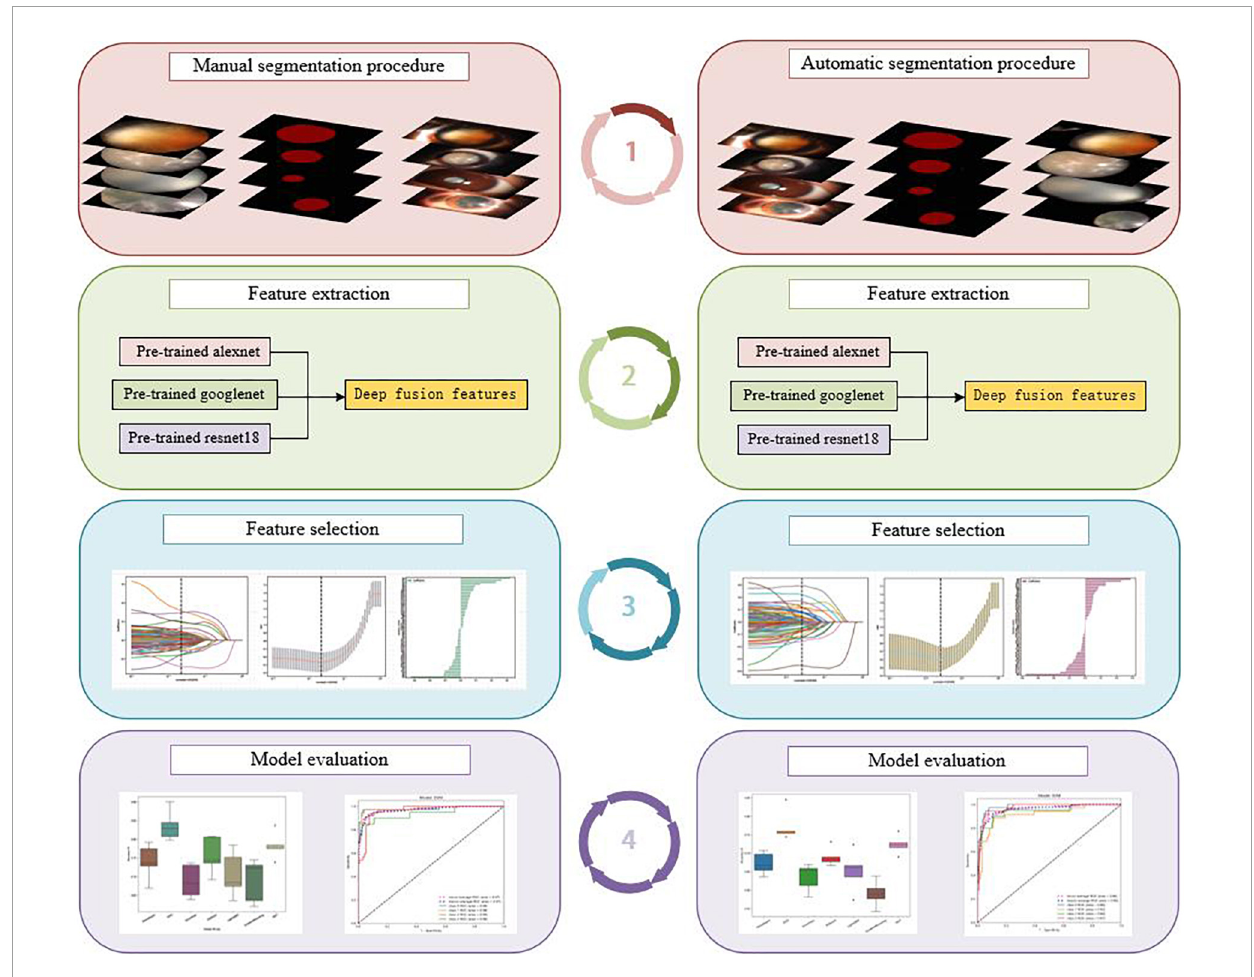
FIGURE1 The flowchart of the detailed processes of the study: manual segmentation procedure (left) , automatic segmentation procedure (right) .